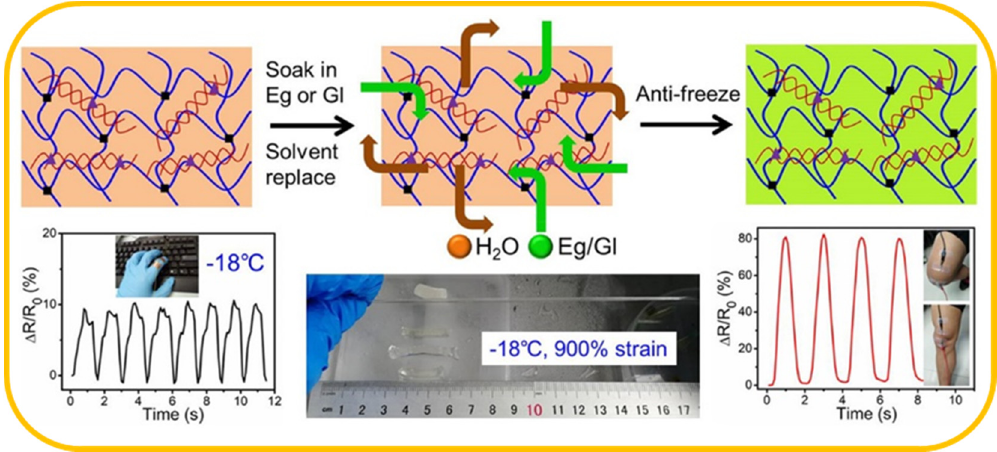
Figure 5. Schematic of a solvent-replacement strategy to fabricate antifreeze strain sensor and the sensitivity of sensor under different conditions.